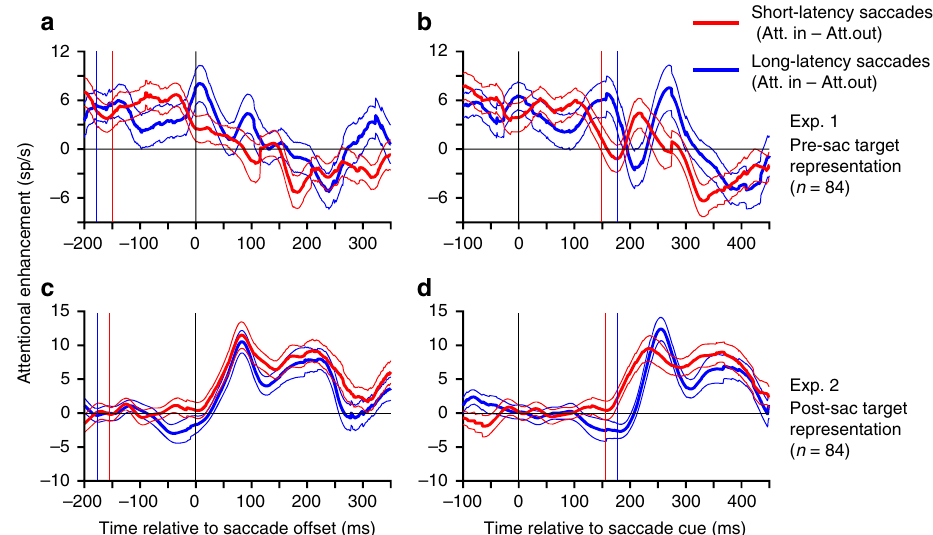
Fig. 3 The trans-saccadic attention shift is synchronized to the saccade, not to fi xation point offset. The time-course of attention shift, plotted separately for trials with saccade latencies shorter than the median (across all attentional conditions for that recording session) and saccade latencies longer than the median, is similar when aligned to saccade offset ( a , c ) but delayed ( b , d ) when plotted aligned to fi xation point offset. Time-course for shorter-latency trials in red and longer-latency trials in blue. The attention shift time-course is de fi ned as in Fig. 2a, b as the difference between the fi ring-rates in the attend-in and attend-out conditions (see Supplementary Fig. 2 for the corresponding PSTHs). Plots show mean difference and s.e.m. Results for Experiment 1 are shown in the top row ( a , b ) and for Experiment 2 in the bottom row ( c , d ). Red and blue vertical lines in each panel represent the mean time of fi xation-point offset ( a , c ) or saccade latency ( b , d ) for trials with short-latency and long-latency saccades, respectively. Data from both monkeys were pooled for this analysis, and trials were dropped as necessary from each condition so as to match the timing distributions of saccade offset for the attend-in and attend-out conditions for each neuron (also see Text and Supplementary Figs. 5 and